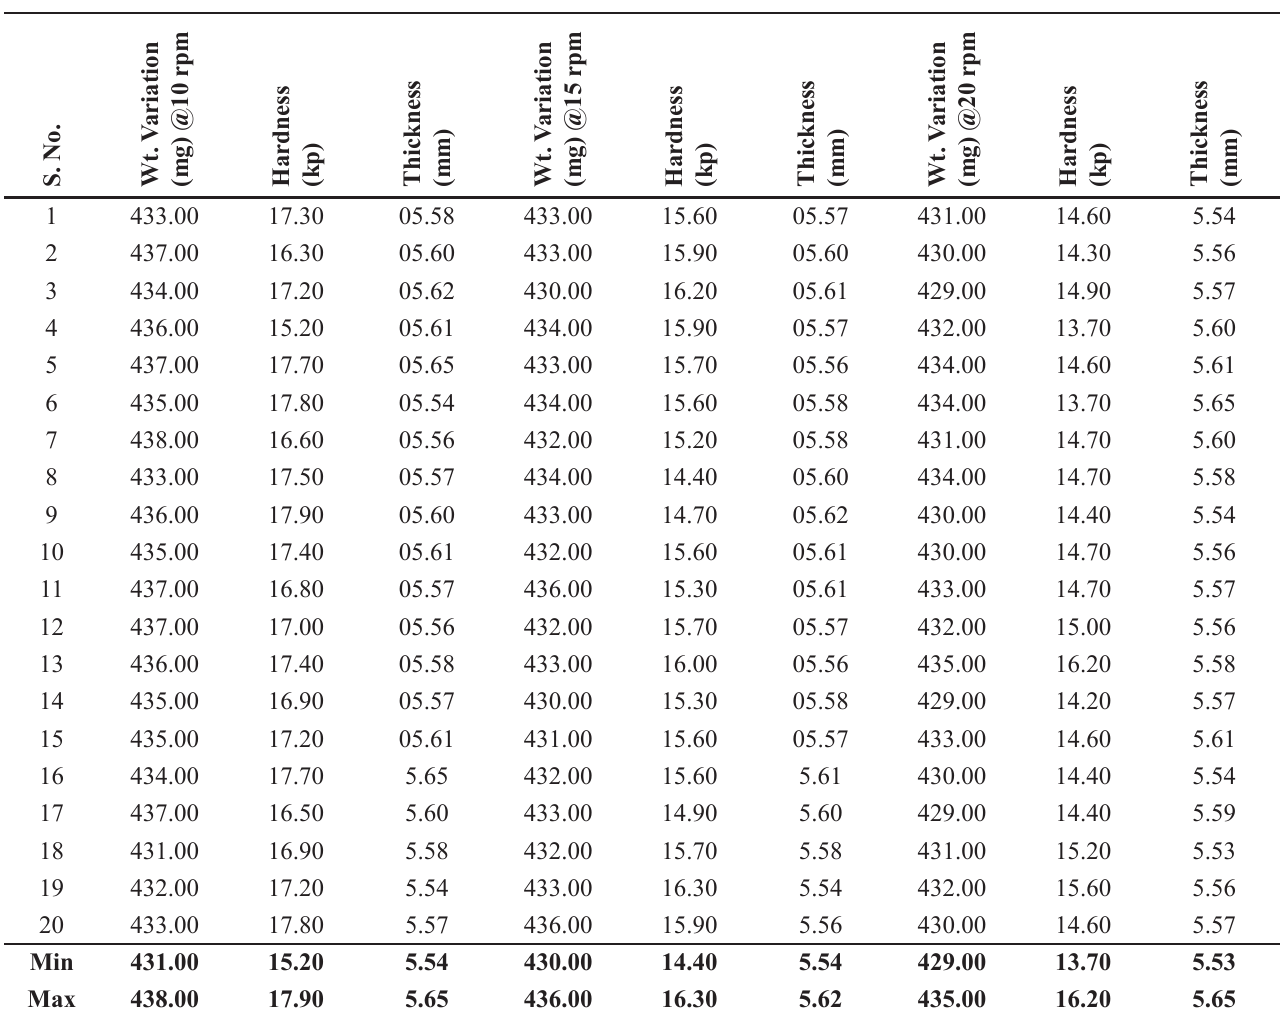
TABLE V - Compression of data for trial no T1B (using force feeder) of 24C screen milled granules